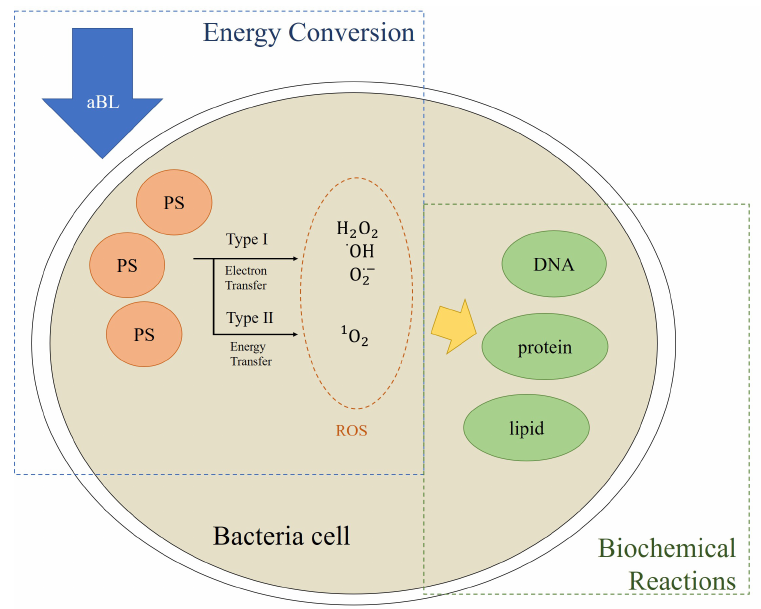
Figure 3. Two stages in the process of antimicrobial blue light